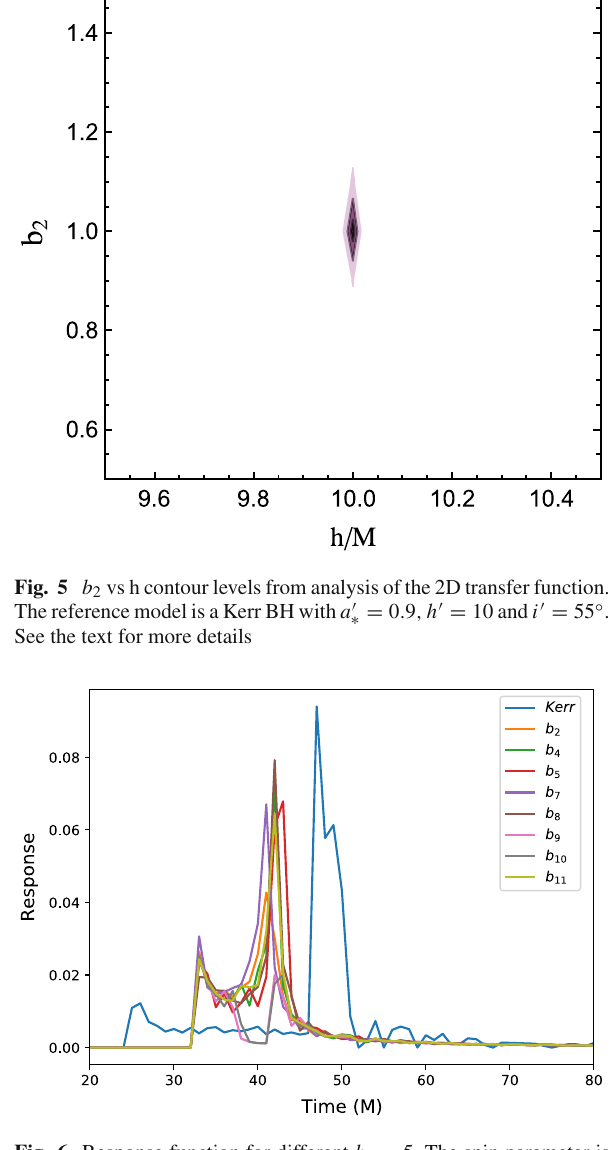
Fig. 6 Response function for different b i = 5. The spin parameter is 0 . 95 and viewing angle is 45 ◦ . The height of the corona is 10 can constrain our Kerr parameters with the exception of b 11